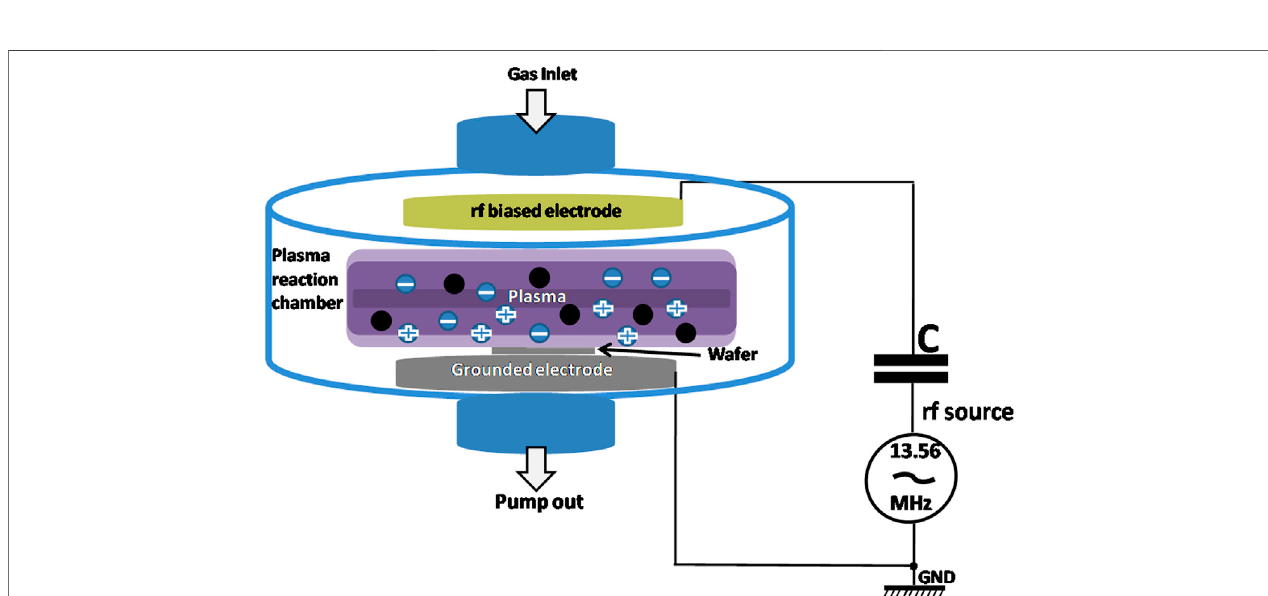
FIGURE 5 | Basic schematic principle of Capacitively Coupled